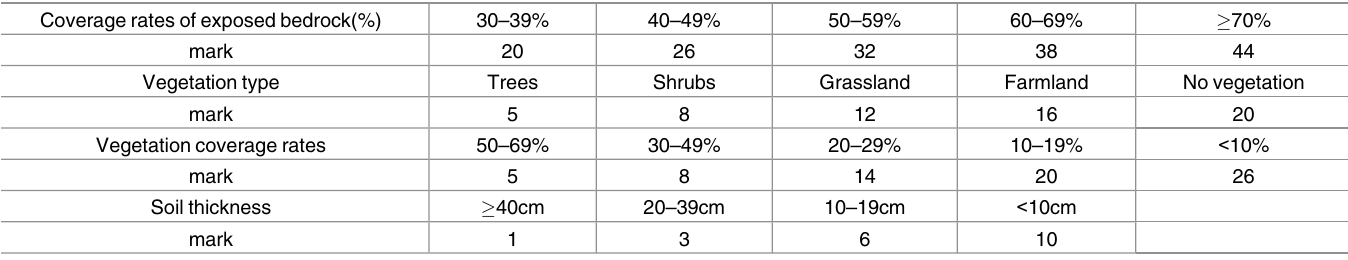
Table 1. Marking standard of the indices for assessing rocky desertification